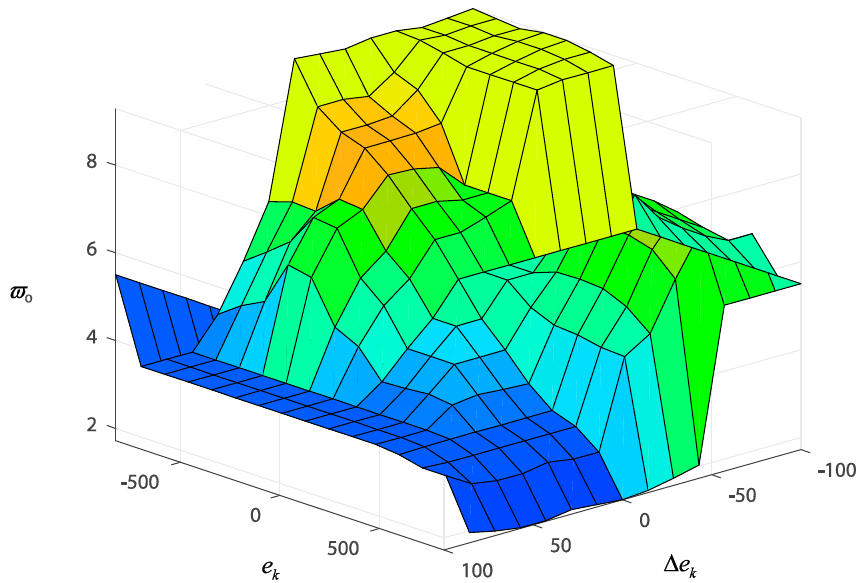
Figure 5. Fuzzy surface of the observer’s bandwidth parameter (cid:118) 0 .